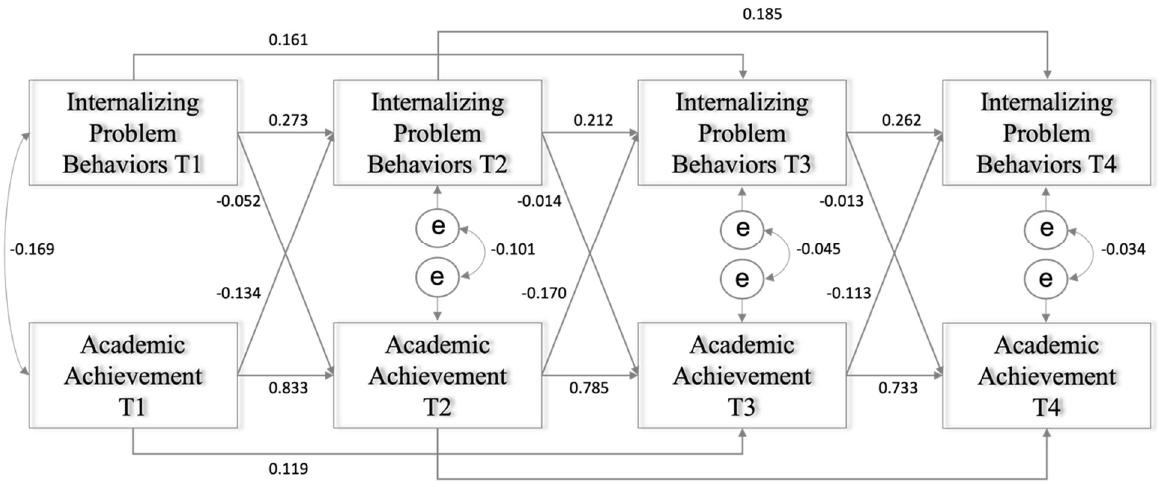
Figure 1. Transactions between internalizing problem behaviors and academic achievement.